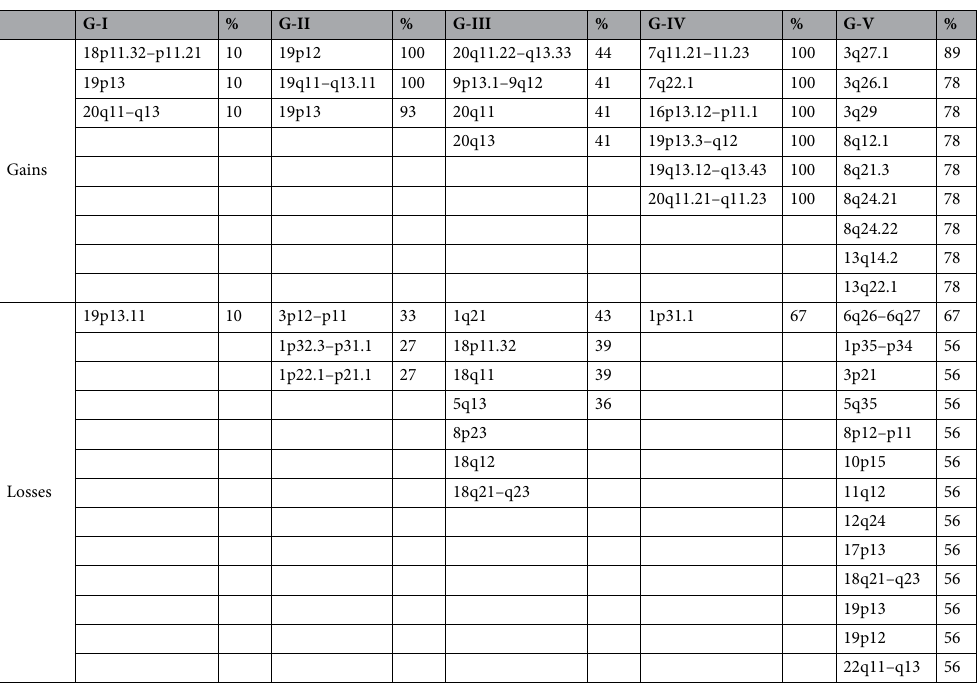
Table 5. Chromosomal segments frequently and differentially altered between the five groups from the MClust analysis. Percents indicate the percentage of tumors with the chromosomal segment alteration within each